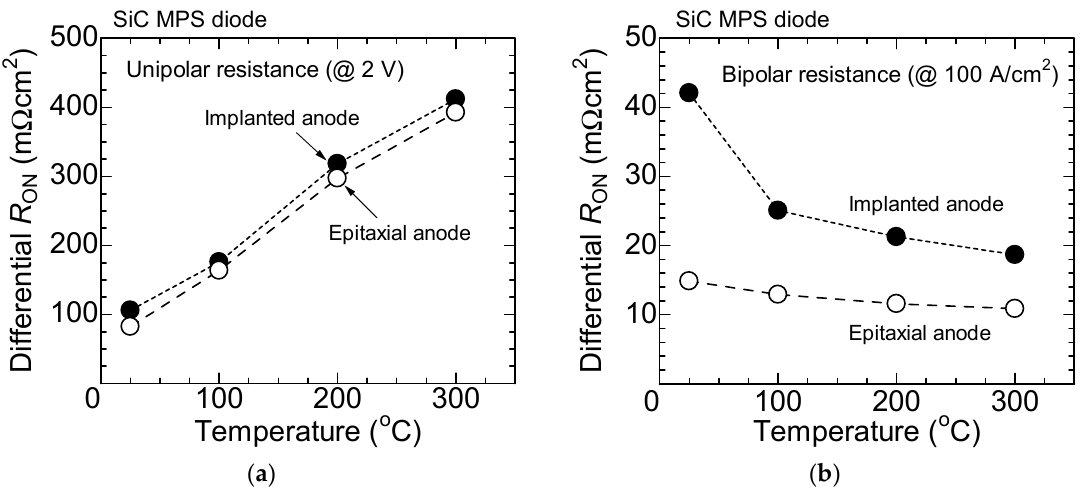
Figure 13. Differential on-resistances of fabricated SiC MPS diodes in the ( a ) unipolar and ( b ) bipolar operations at different temperatures. The results for epitaxial and implanted MPS diodes are shown.